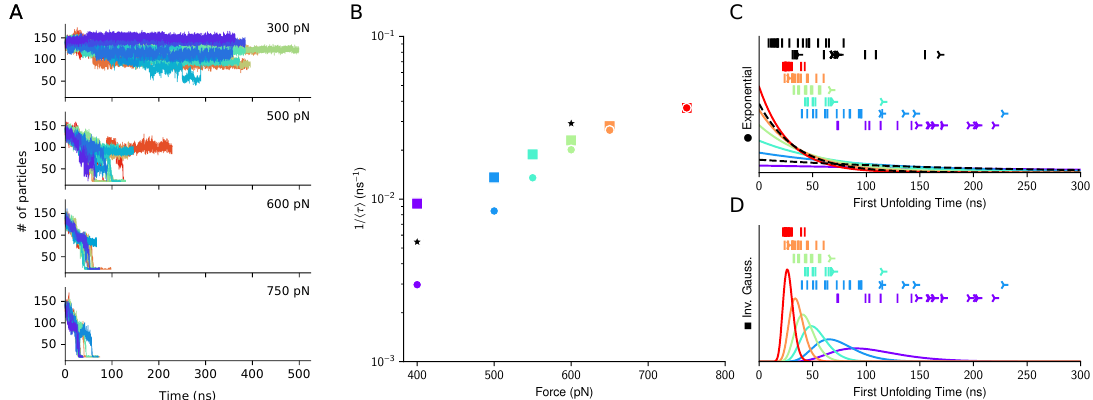
Figure 2. Exposure of the cleavage site upon force-clamp unfolding. Panel ( A ). Time evolution of the coordination number of 111 Tyr under the action of mechanical forces of different magnitudes in coarse-grained simulations. At the beginning the residue is buried in the protein matrix, and the number of protein backbone atoms in its proximity is the highest. During unfolding this number decreases as a sign of progressive exposure out of the protein matrix. For each force value, up to 20 independent simulations were run. Panel ( B ). Kinetics for the cleavage site exposure. For the CG model the inverse mean first unfolding times is estimated for the exponential (circles) and inverse Gaussian (squares) distributions. For all-atom simulations only the exponential model is used (black stars). Panels ( C , D ). The estimated distributions are shown (solid lines) together with the simulated unfolding times (vertical bars) or end of not-yet-unfolded trajectories (three-pointed